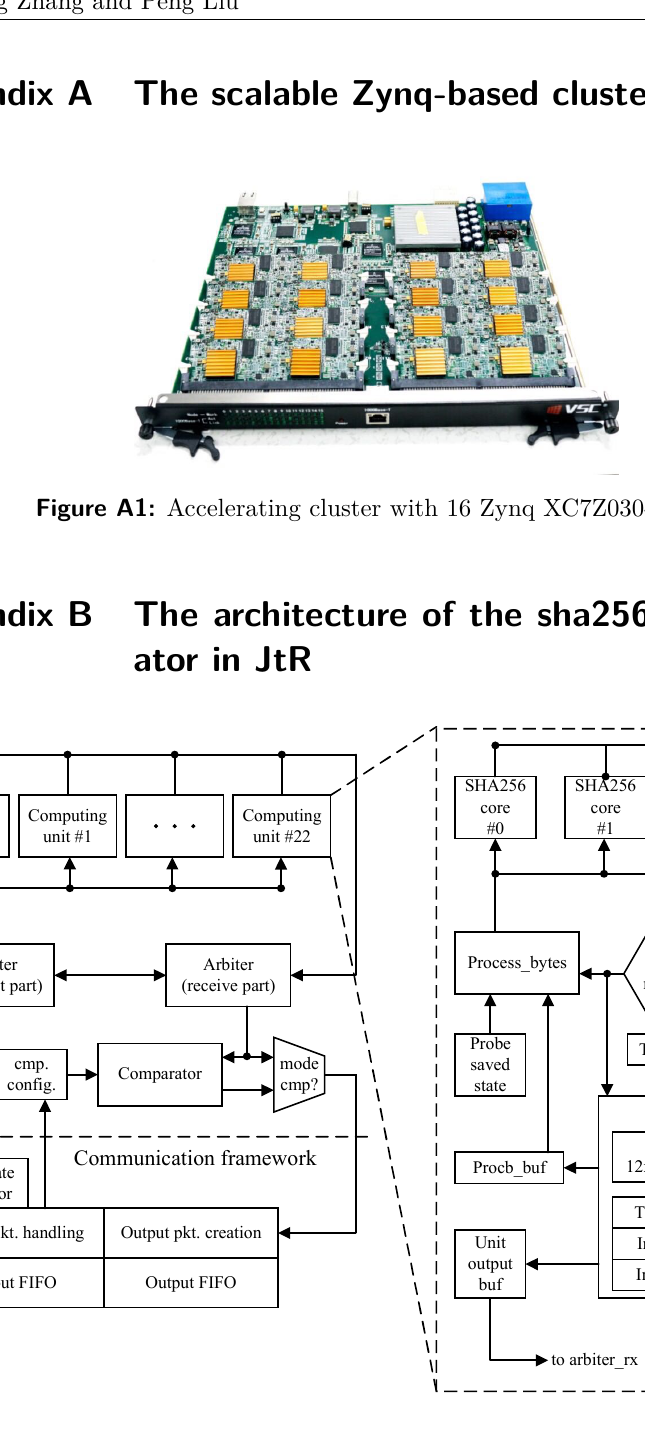
Figure B1: The detailed architecture of the sha256crypt accelerator in